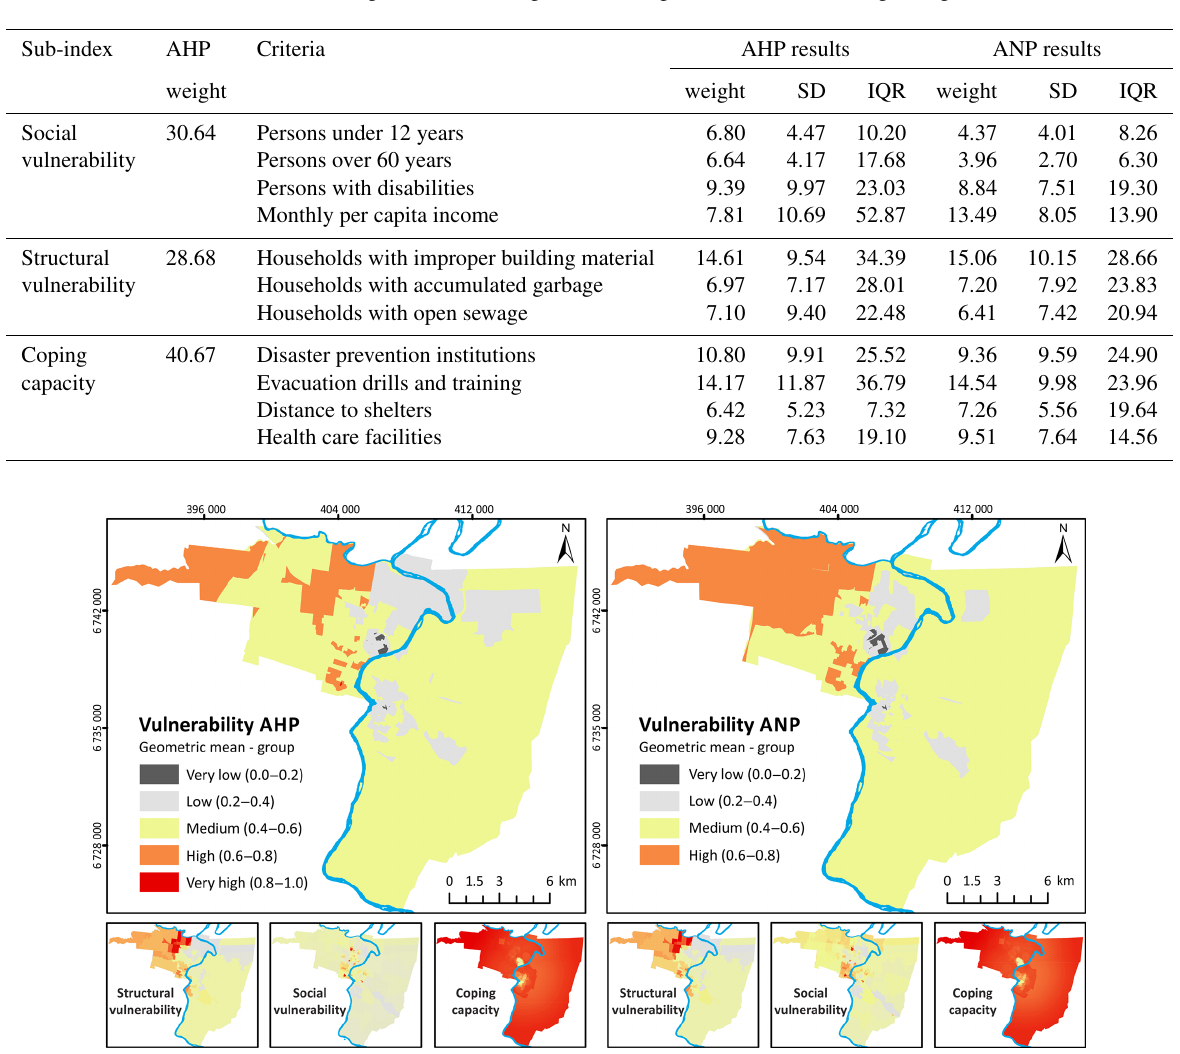
Table 3. Group criteria weights and their respective standard deviation (SD) and interquartile range (IQR). An IQR of 20% or less indicates